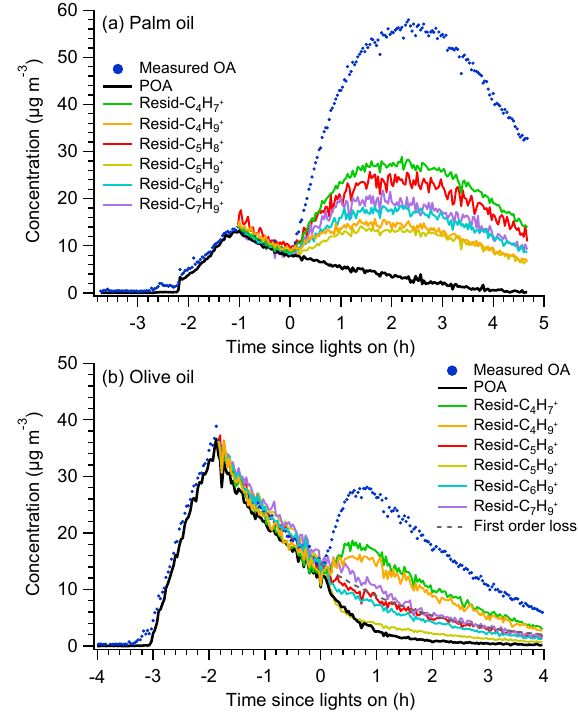
Figure 3. Time series of measured OA, PMF-derived POA factors, and POA determined using the residual method for (a) palm and (b) olive oil